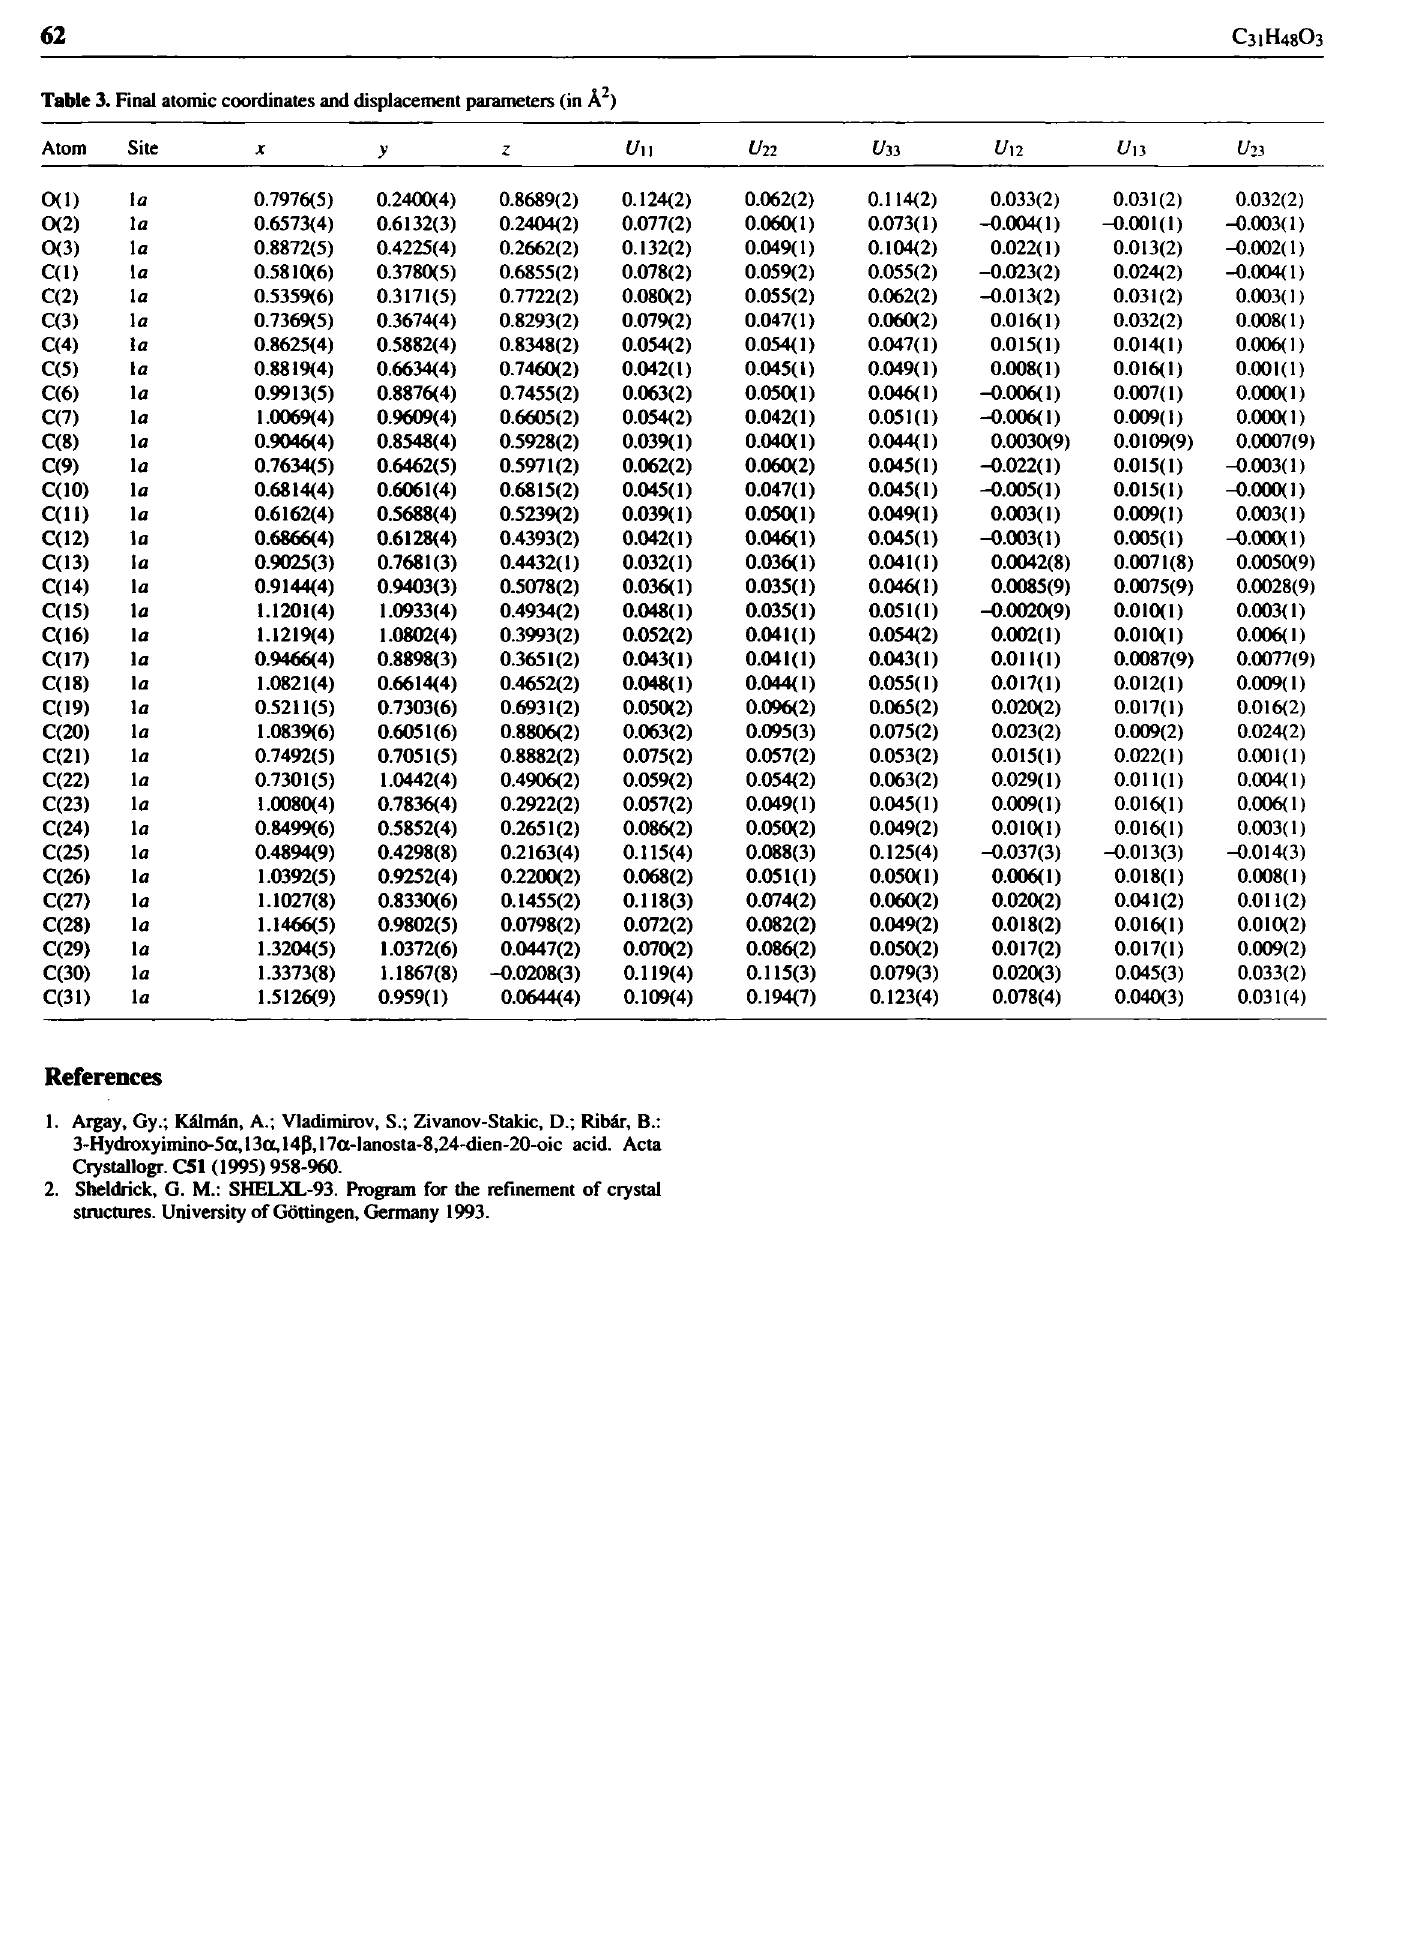
Table 3. Final atomic coordinates and displacement parameters (in Â 2